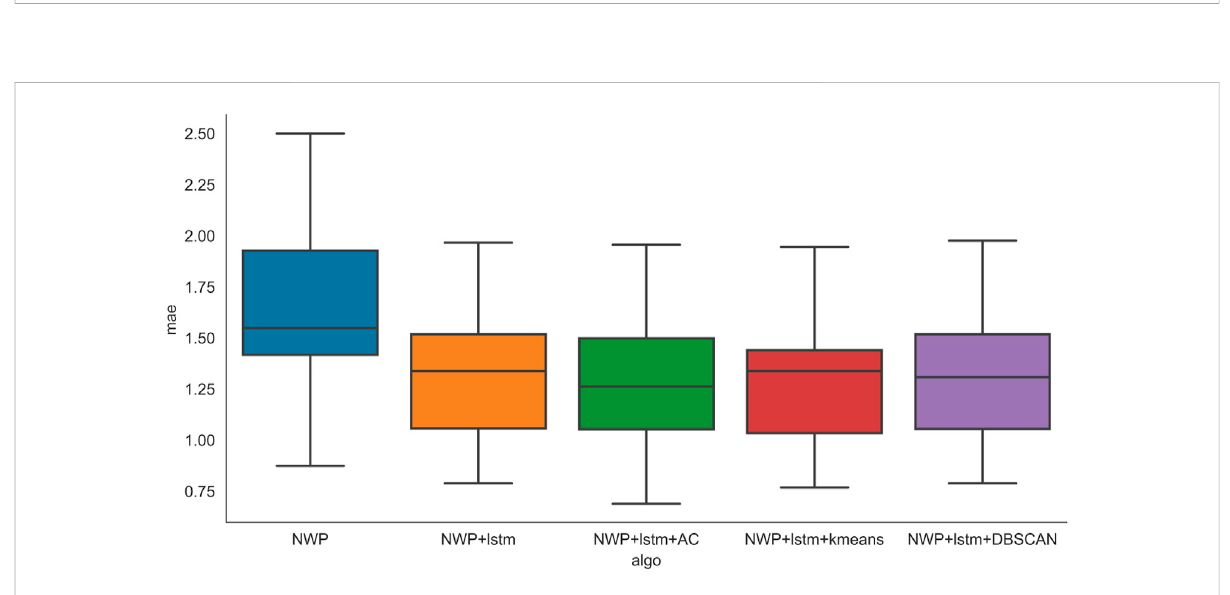
FIGURE 13 Overall mae results for different clustering methods based on the